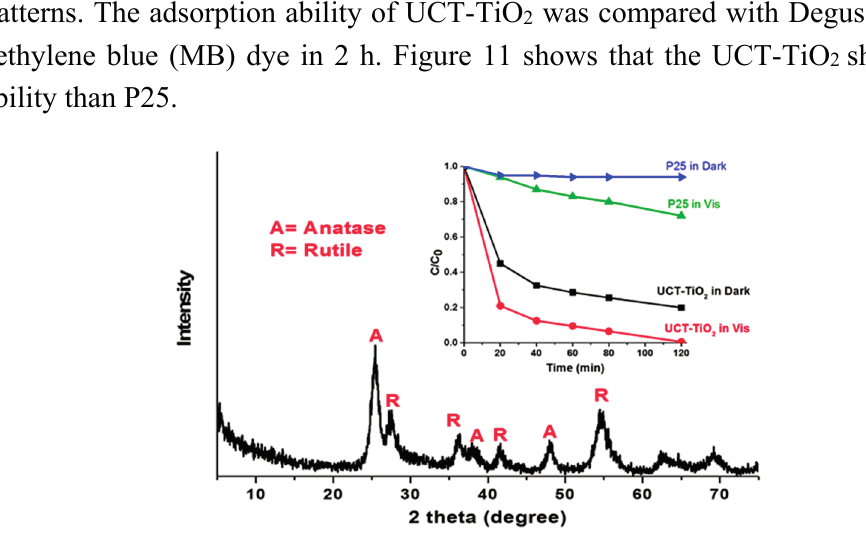
Figure 11. X-ray diffraction pattern for UCT-TiO 2 materials. Inset image: adsorption ability and photocatalytic ability of UCT-TiO 2 compared to P25 tested in dark and visible light conditions, respectively. The efficiency was calculated by C/C 0 (dye concentration in different time/initial dye